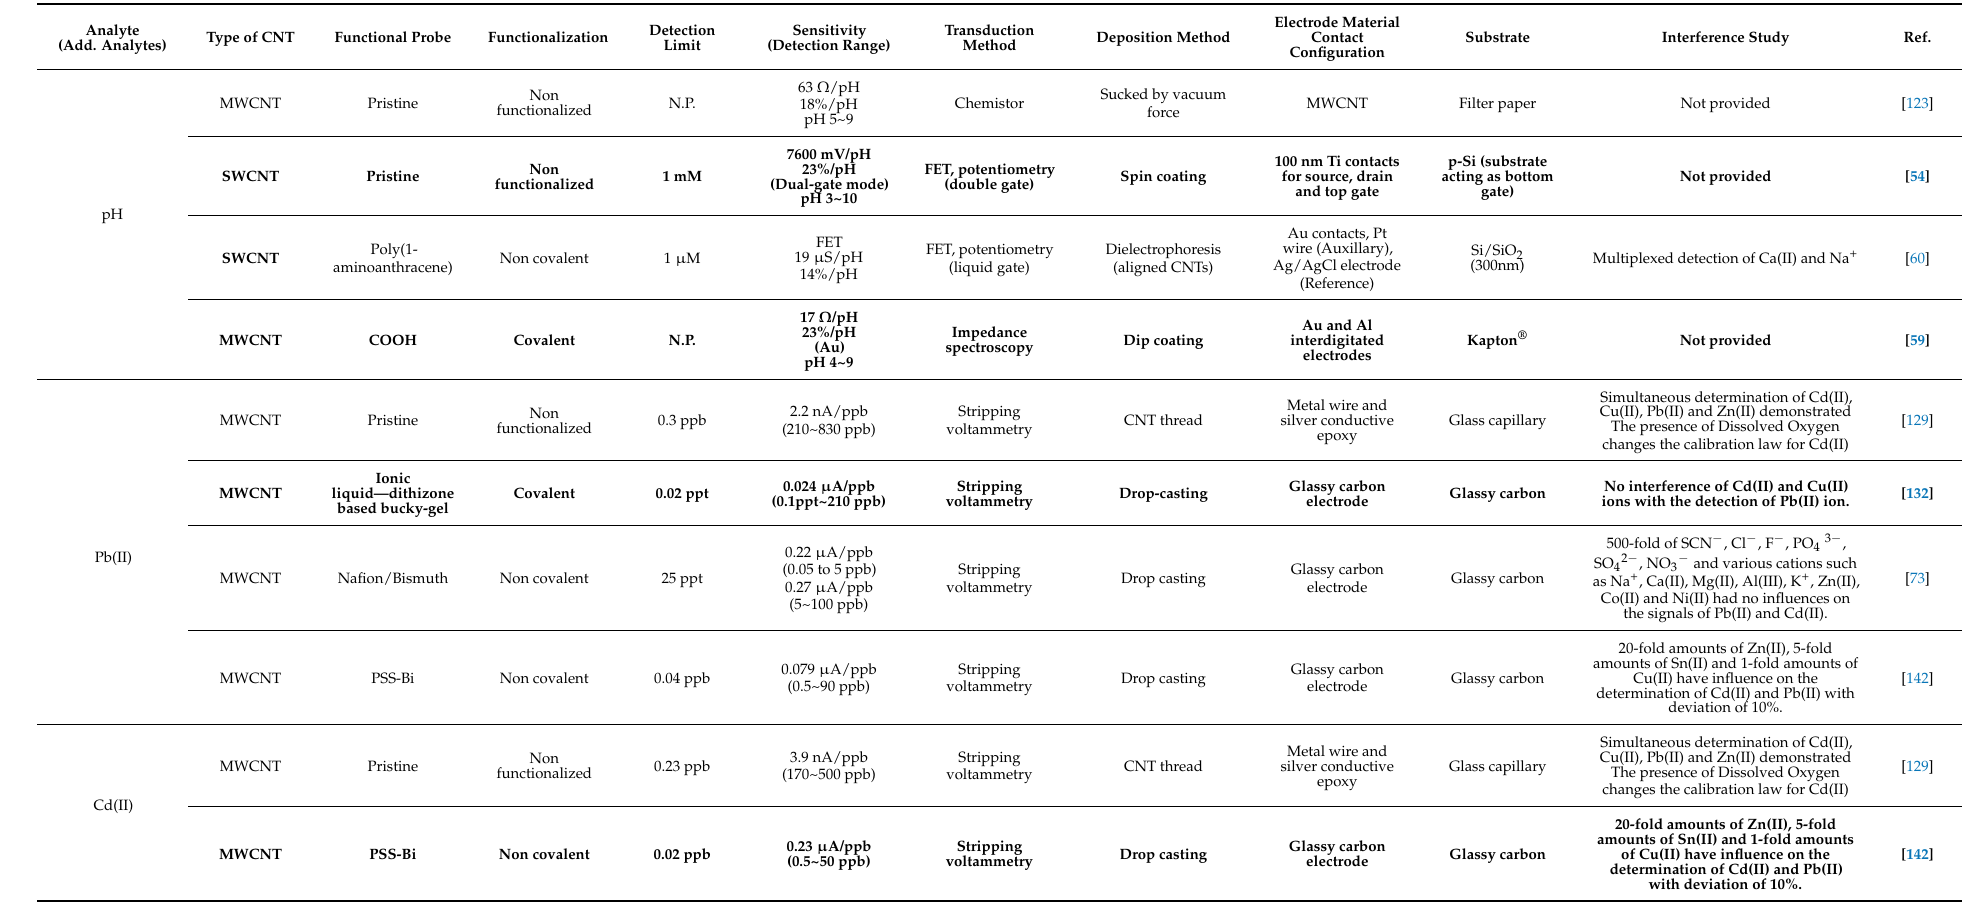
Table 17. Summary of best performances for all analytes addressed by more than one reference. When several transduction types or functionalization strategies are available for a given analyte, the table includes the best performing reference for each